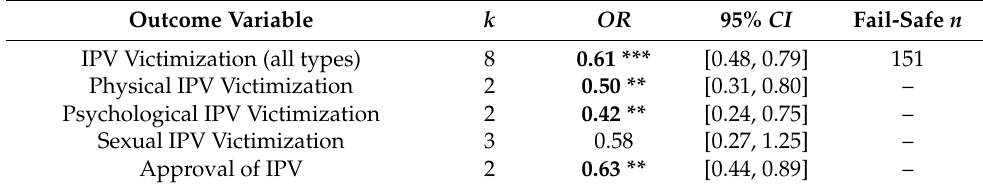
Table 2. Meta-analysis results examining IPV outcomes for women and community programming. Outcome Variable